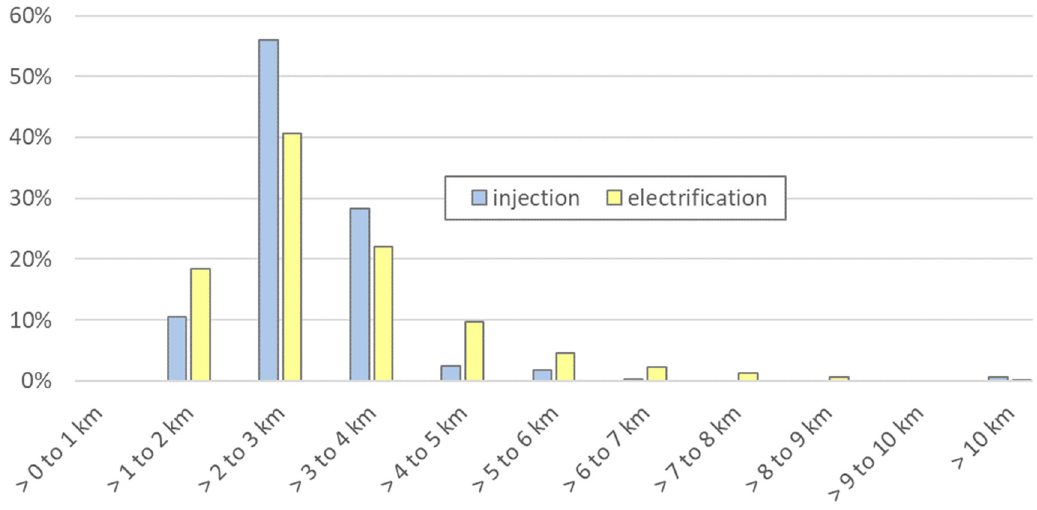
Figure 3. Frequency distribution of average haul distance (own analysis).